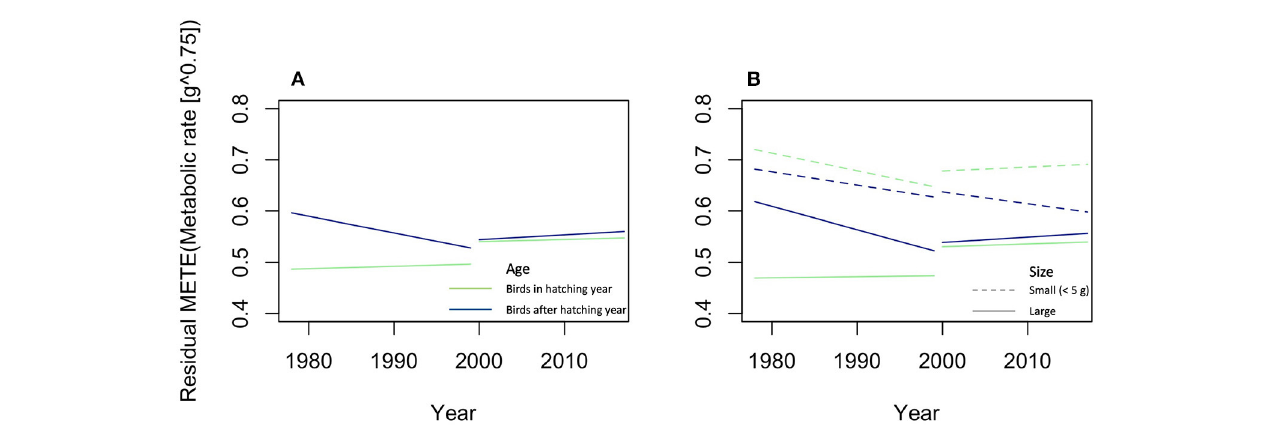
FIGURE3 Results of the METE-analysis of the metabolic rate of North American migration birds. Lines are the predicted changes in (A) residuals of the METE predicted metabolic rate ignoring body size and (B) including the difference between small and large birds. Green lines are hatchlings, blue lines older birds, solid lines are large ( ≥ 5g), and dashed lines small birds. Predictions were made with linear models, lm() in R version 4.0.3 [56], with age, year, period, and size [only in (B) ], and all their interactions as independent variables. A description of this analysis is given in Appendix 2. To draw these graphs, the variable sex and random effect variable year were ignored, in comparison with the models in Table A2.4 in Appendix 2.